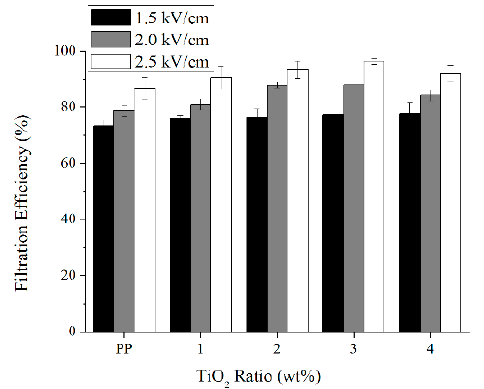
Figure 5. Filtration efficiency of electret melt-blown fabrics as related to the ratio of TiO 2 (1, 2, 3, and 4 wt%) and electric field intensities of (a) 1.5, (b) 2.0, and (c) 2.5 kV/cm. The filtration efficiency of non-electret pure polypropylene (PP) melt-blown fabrics is 72.67% ± 1.42%.